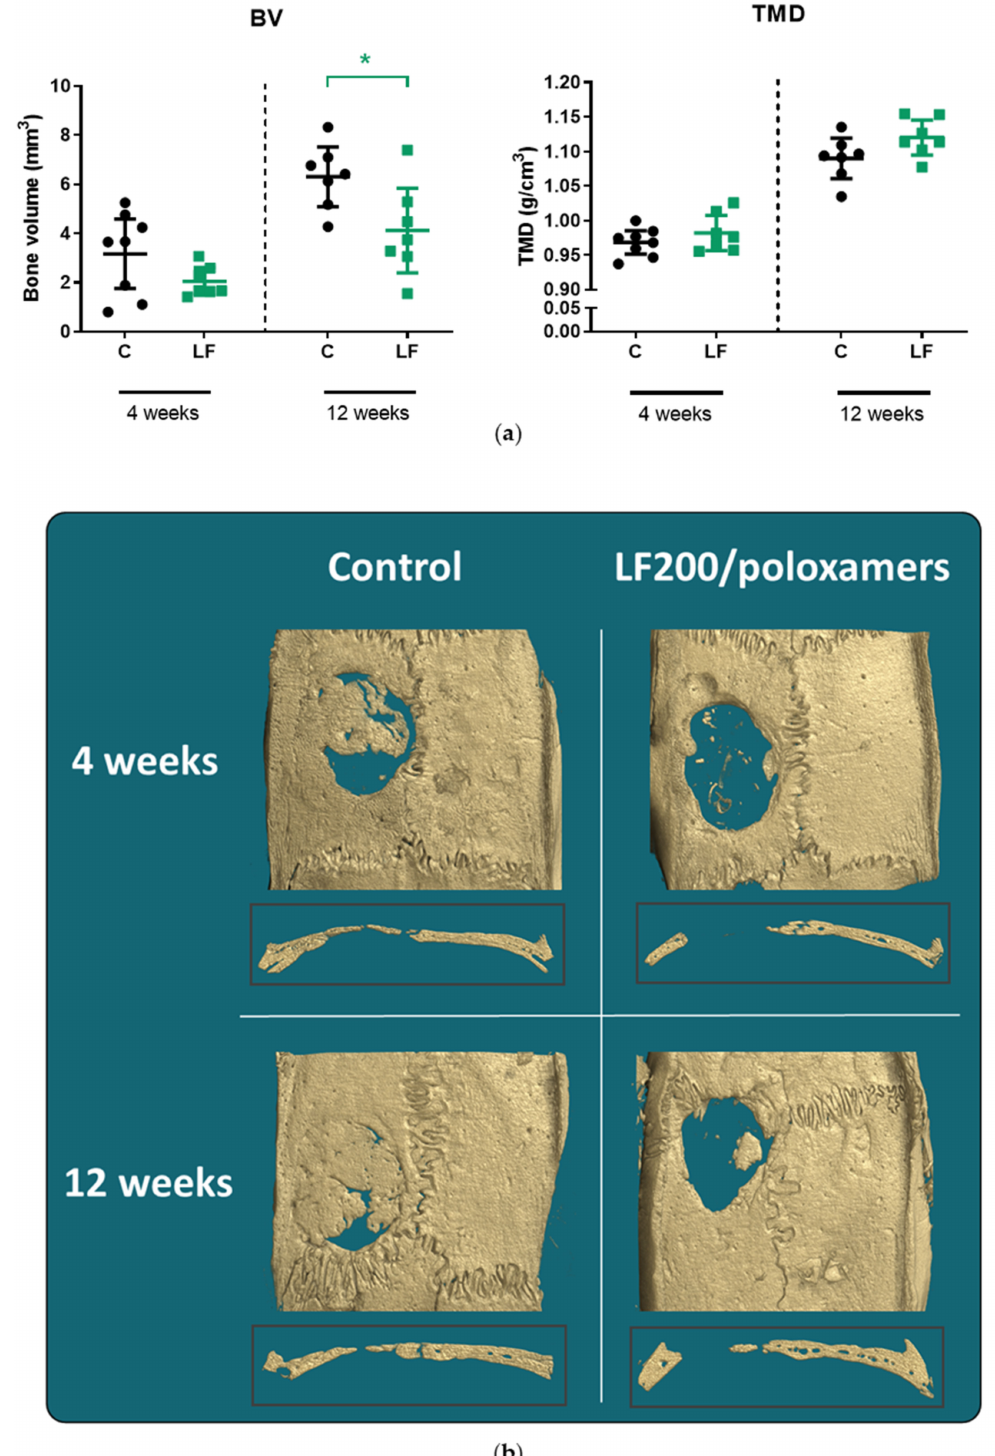
Figure 5. MicroCT results of rat calvariae at 4 and 12 weeks postoperation. ( a ) Bone volume and tissue mineral density of the control and LF200/poloxamer groups. C, Control; LF, LF200/poloxamer; BV, bone volume; TMD, tissue mineral density. Data shown are the mean ± 95% CI; two-way ANOVA with post hoc Dunnett’s test, * p < 0.05 versus the control at that time point. ( b ) Reconstructed bone images of rat calvariae using the microCT data. The median bones from the bone volume data in each group are presented with cross-section at the middle of the defect